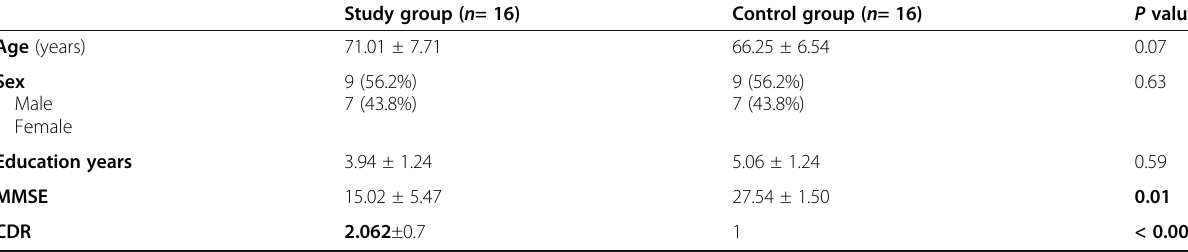
Table 1 Baseline data of studied